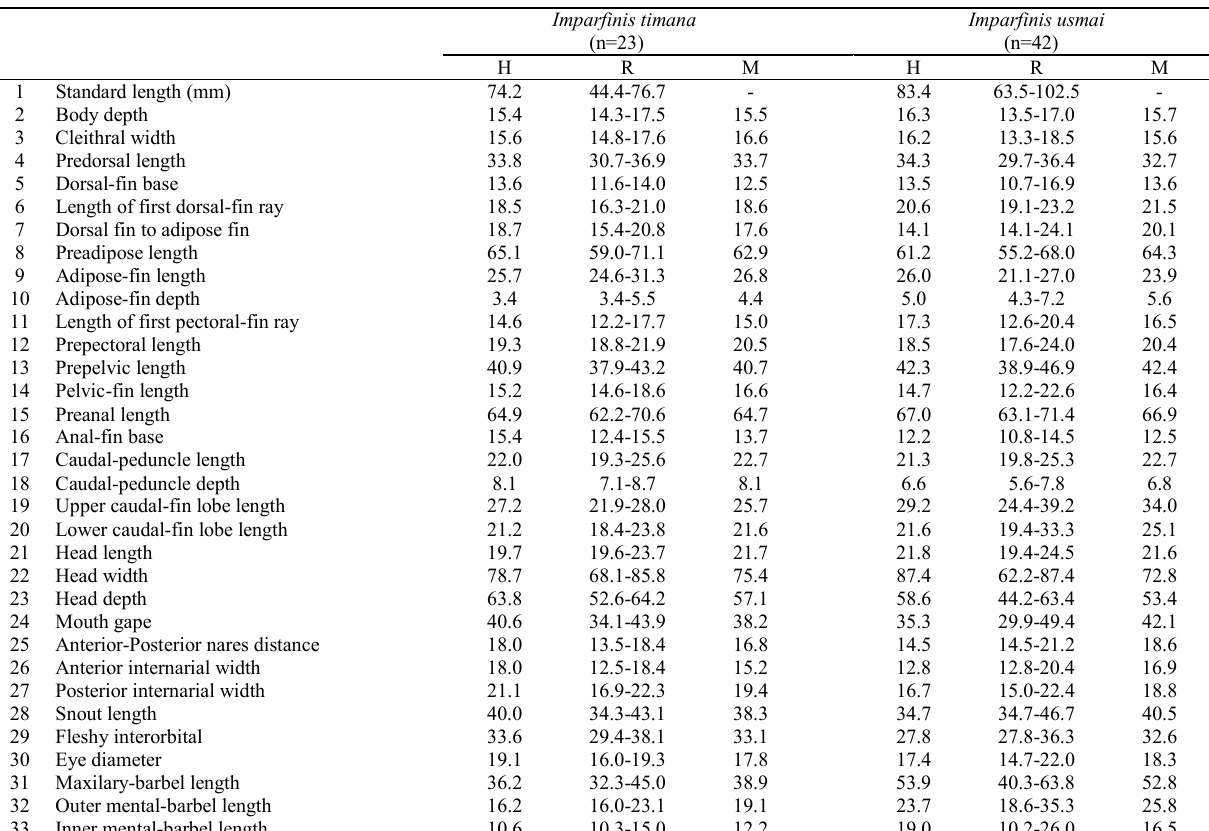
Table 1. Morphometric data for holotype and measured paratypes of Imparfinis timana and I. usmai . Measurements 2 to 21 and 31 to 33 expressed as percents of standard length and 22 to 30 as percents of head length. H: holotype; M: mean; R: